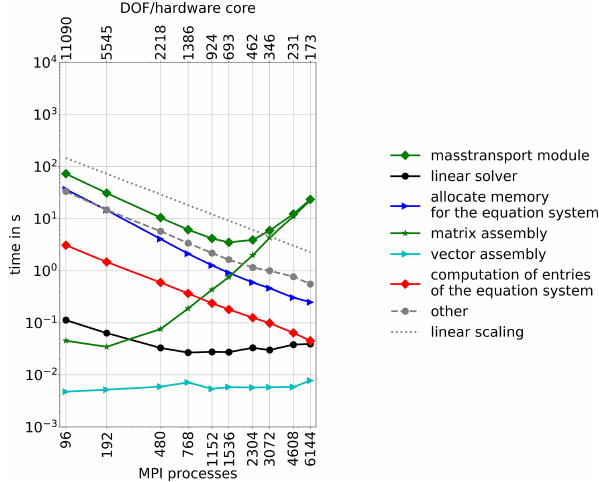
Figure 7. Runtime of the mass transport module for G250.